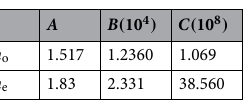
Table 1. Cauchy coefficients for the indices of the LC mixture 1929 ( (cid:31) in nm)